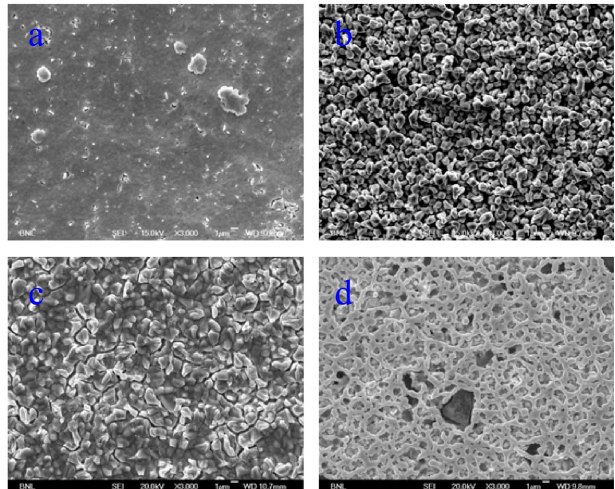
FIG. 7. (Color) Lead cathode surface morphology after irradia- tion with 0 : 2 mJ = mm 2 : (a) arc-deposited, (b) sputtered, (c) evaporated, (d) polished solid lead.